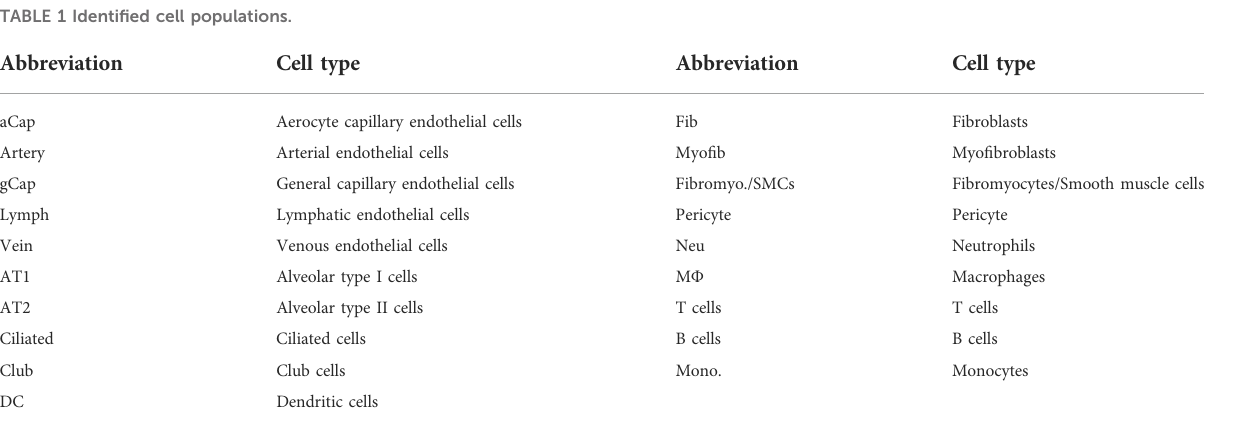
TABLE 1 Identi fi ed cell